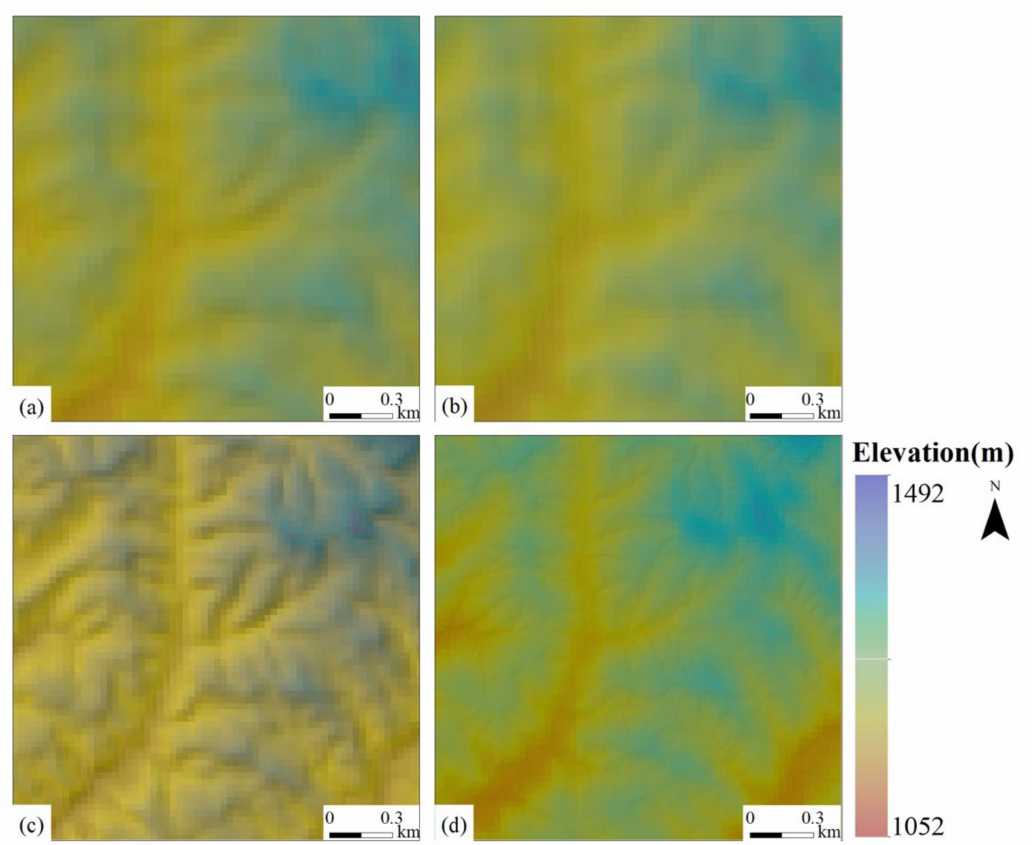
Figure 2. The experimental data. ( a – d ) are hill shade maps of the SRTM1 DEM, ASTER GDEM V3, AW3D30 DEM, and reference